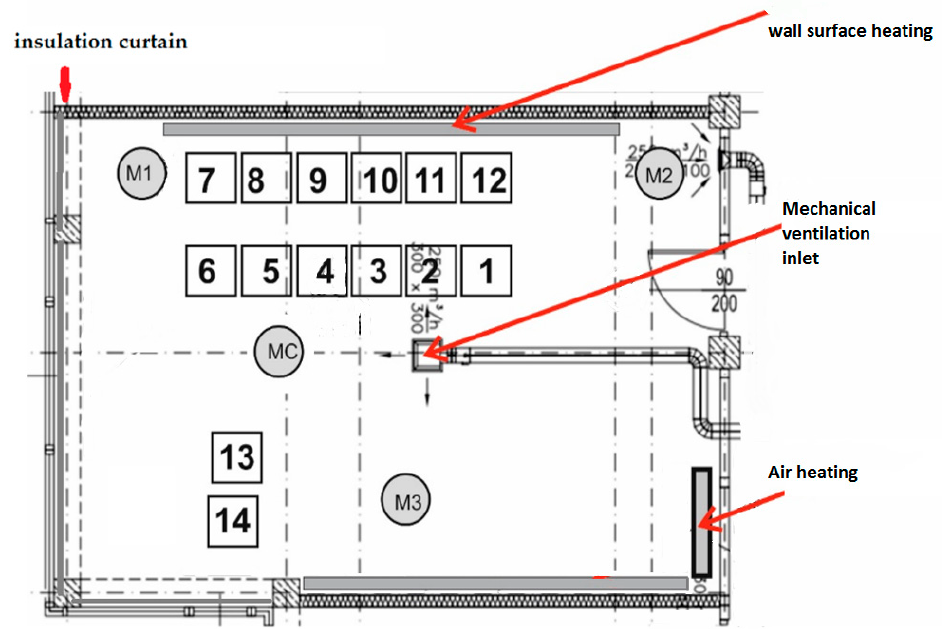
Figure 2. Chamber for measuring indoor comfort (where 1–14 are seats for participants in the sensory tests, M1–M3 are devices for generating high humidity, and MC is the location of microclimate